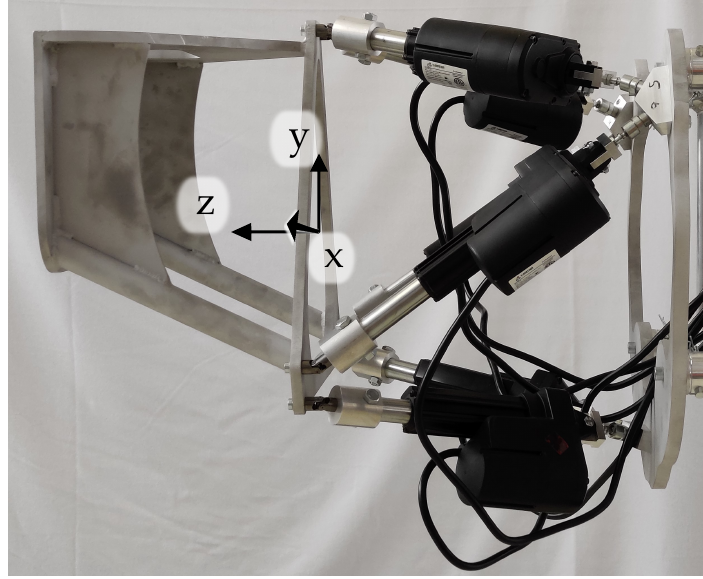
Figure 9. Coordinate system of the Stewart platform. The first experiment contemplated the ability to twist the flap body by the angle α when the Stewart platform rotates around the z-direction (see Figures 9 and 10). The